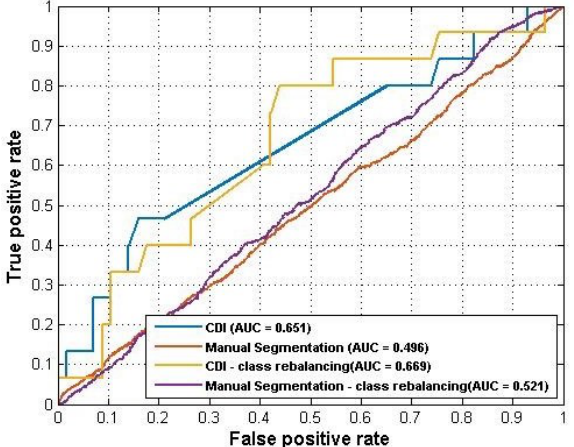
Figure 3. Receiver operating characteristic (ROC) plot of bottom CDI (#1, #2, and #3) and manual segmentation on X1 slice.